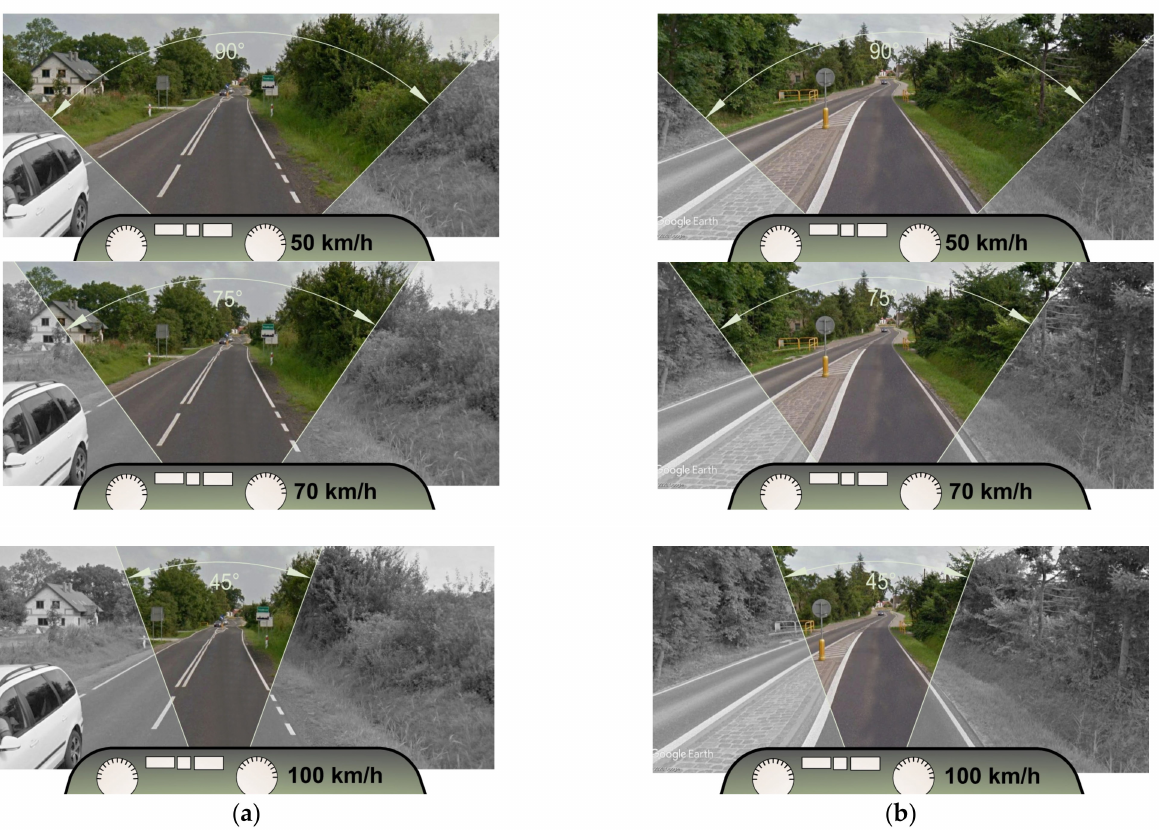
Figure 7. A visualisation of the central and peripheral vision areas on section No. 6 with a speed reduction of ∆ v 85 = 9.4 km/h: ( a ) 100 m before chicane at v : 50, 70 and 100 km/h; ( b ) in the axis of the chicane at v : 50, 70 and 100 km/h. (Background photographs source: Google Earth